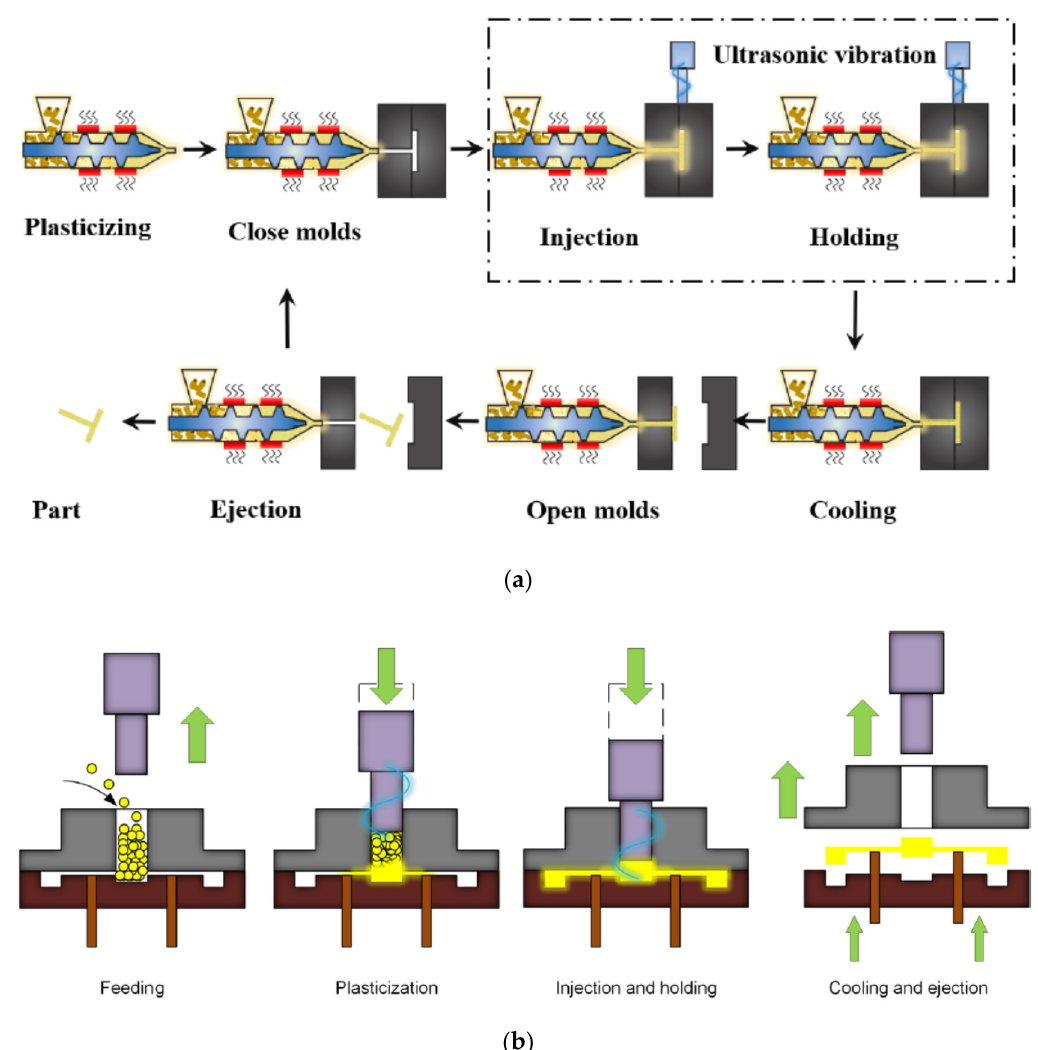
Figure 5. Schematic diagram of ( a ) UAMIM and ( b ) UPMIM. Adapted, with permission, from [73]. 2021, MDPI AG.